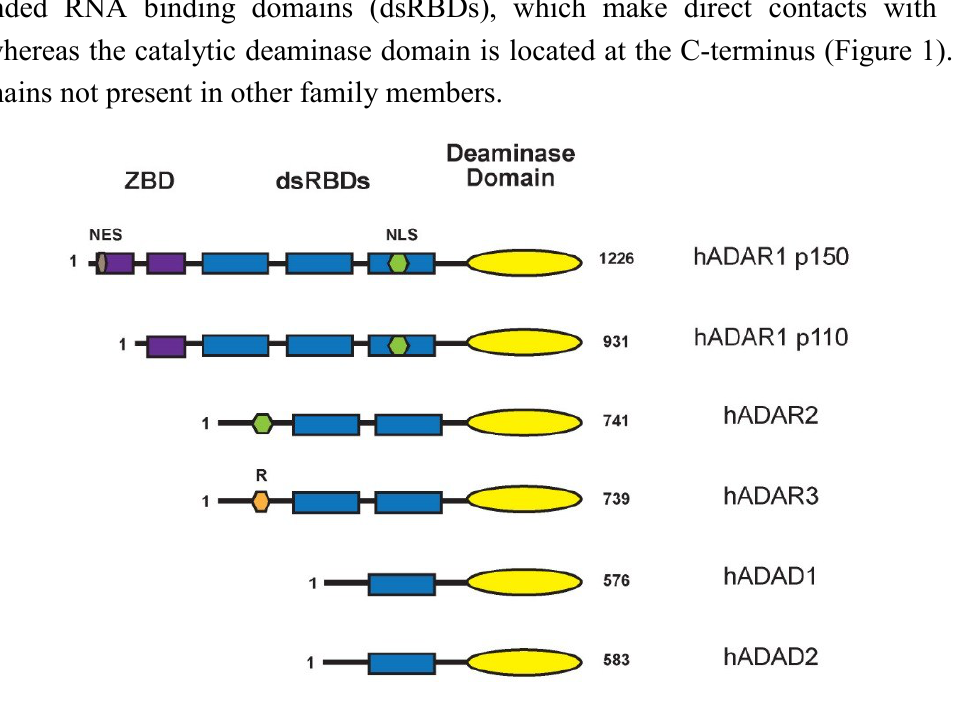
Figure 1. Domain organization of ADAR and ADAD proteins expressed in Homo sapiens . All of the proteins contain N-terminal dsRBDs and C-terminal deaminase domains. An arginine rich (R) region is present at the N-terminus of ADAR3. There are two isoforms of hADAR1, ADAR1 p110 and ADAR1p150, both of which contain a Z-DNA binding domains (ZBD) at the